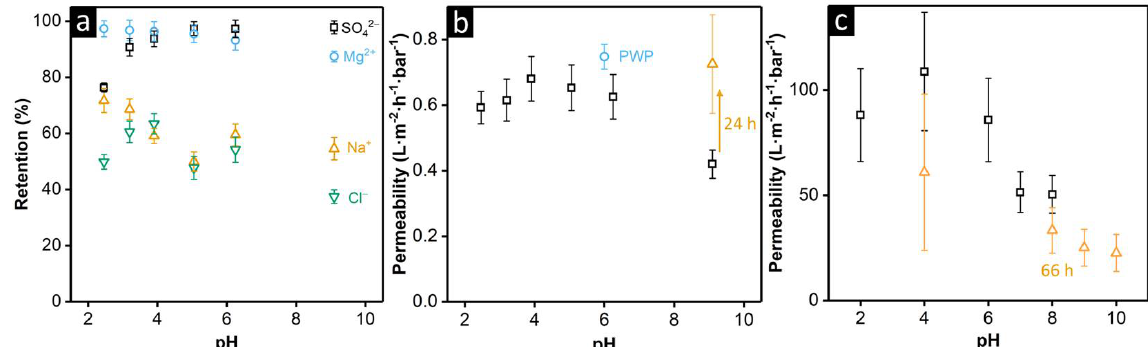
Figure 4. ( a ) Retention of various ions at different feed solution (5 mM of MgSO 4 plus 5 mM of NaCl) pH values by the PSaMA NF membranes. ( b ) Permeability of the PSaMA NF membranes under the different pH conditions from ( a ), and the pure water permeability (PWP) measured with deionized water. At pH 9.1, the permeability had significantly changed after 24 h, shown by the second data point at pH 9.1 ( ∆ ). ( c ) The water permeability of the PSaMA UF membranes of 0.02 M buffer solutions at different pH values measured over several hours from low to high pH, after which the permeability at pH 4 was measured again. At pH 8, a long-term experiment (66 h) was performed, after which reduced permeability values were observed ( ∆ ). The error bars indicate the standard deviation of measurements from 4 different membrane samples.